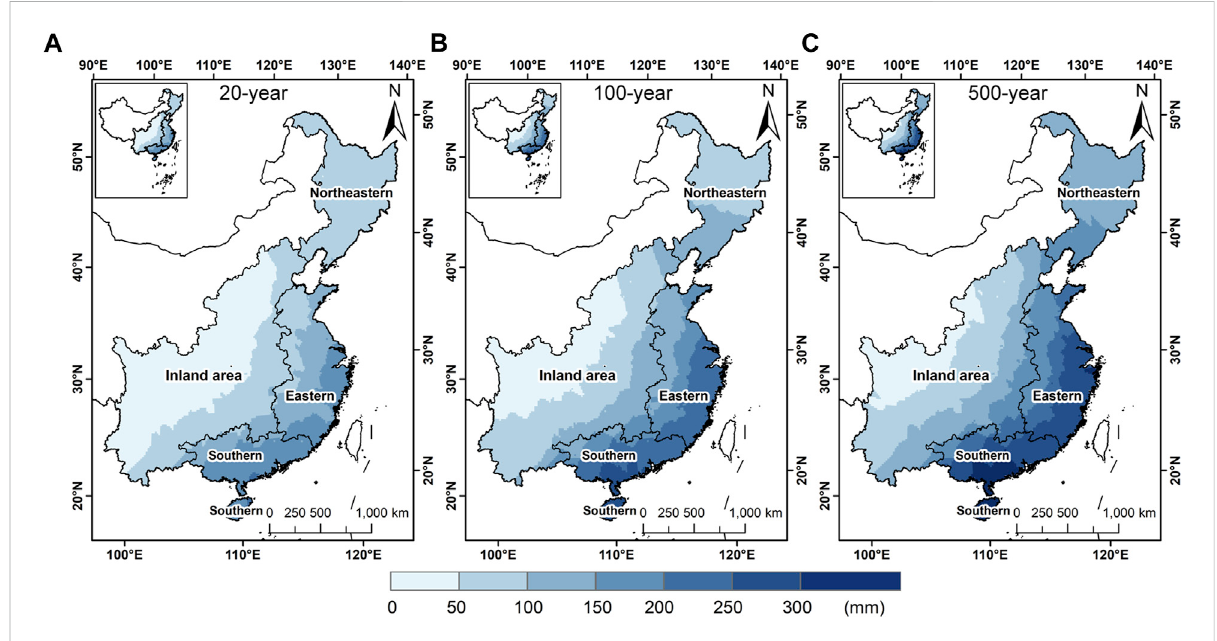
FIGURE 15 Distribution of the daily extreme TCP of the (A) 20-, (B) 100-, and (C) 500-years return